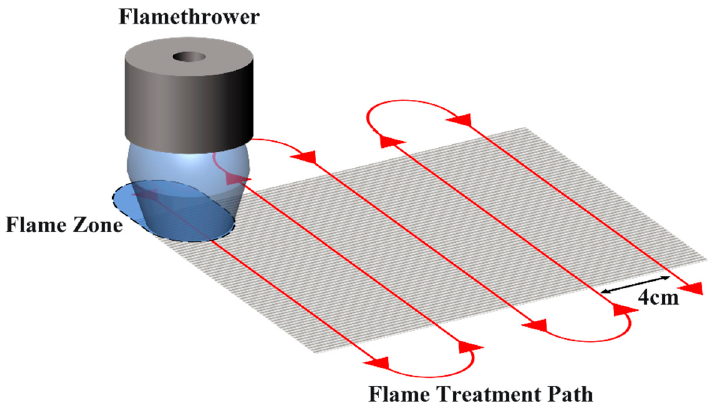
Figure 3. Flame treatment diagram.